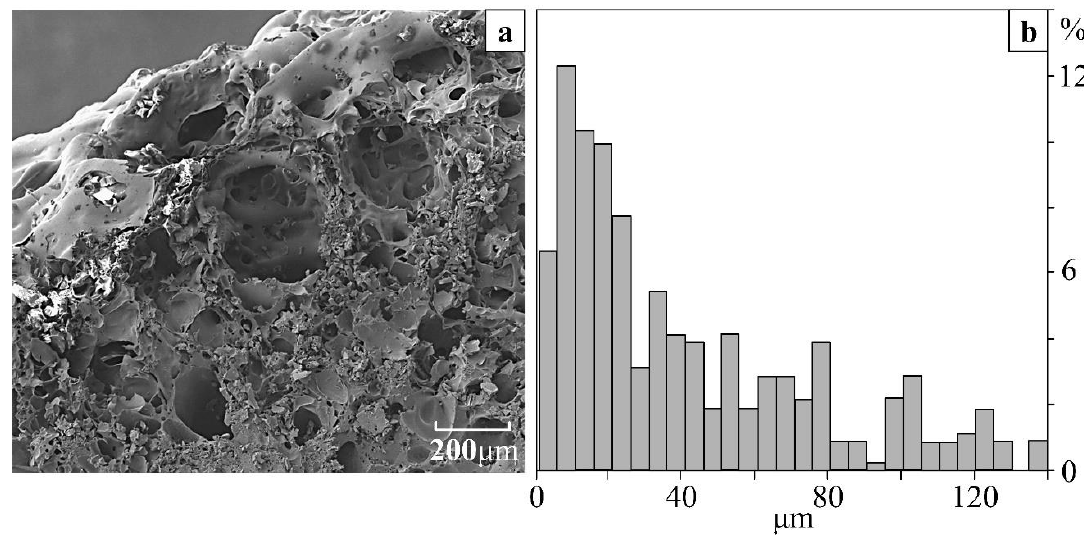
Figure 7. ( a ) SEM image of the coke cap and ( b ) the relative size distribution of pores after the combustion test of composition.